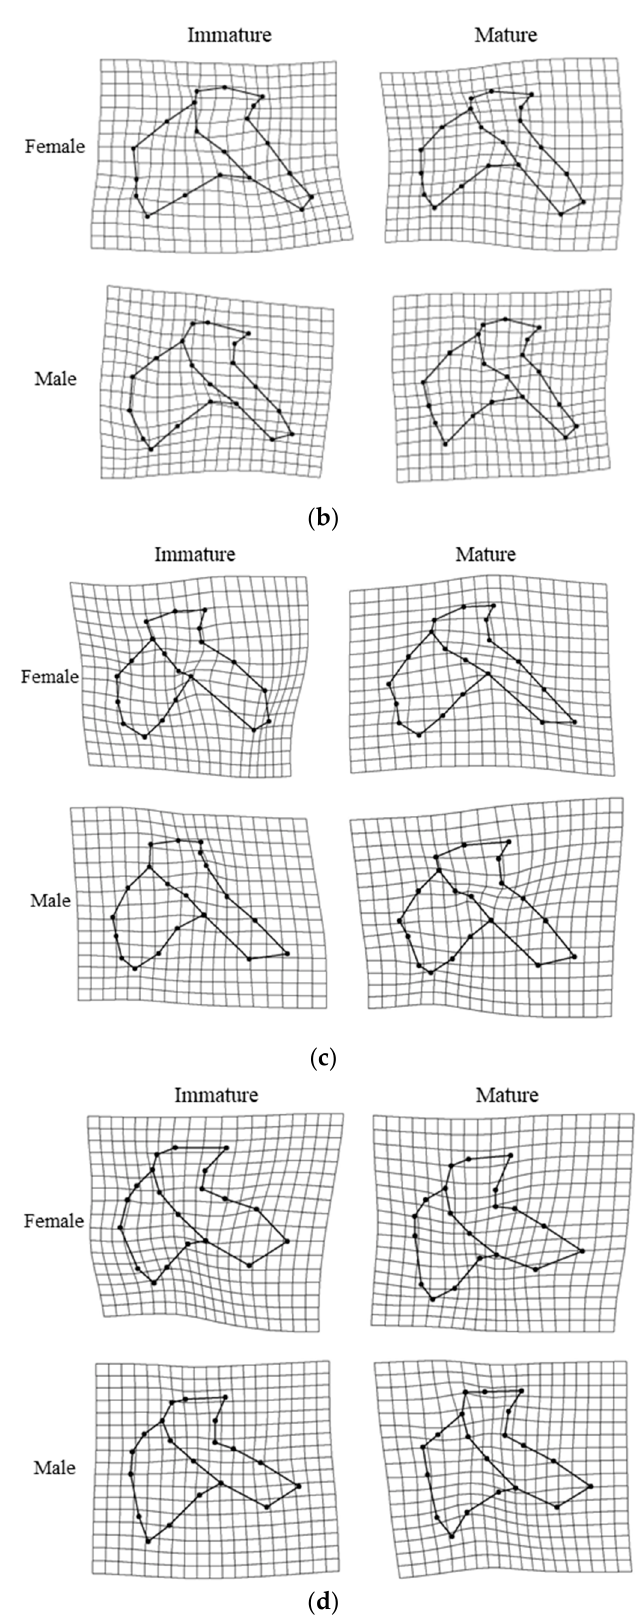
Figure 7. Thin-plate spline deformation grids of lower beak of the four cephalopods considered in different ontogenetic stages. ( a ) Octopus minor . ( b ) Uroteuthis edulis . ( c ) Sepia esculenta . ( d ) Sthenoteuthis oualaniensis .